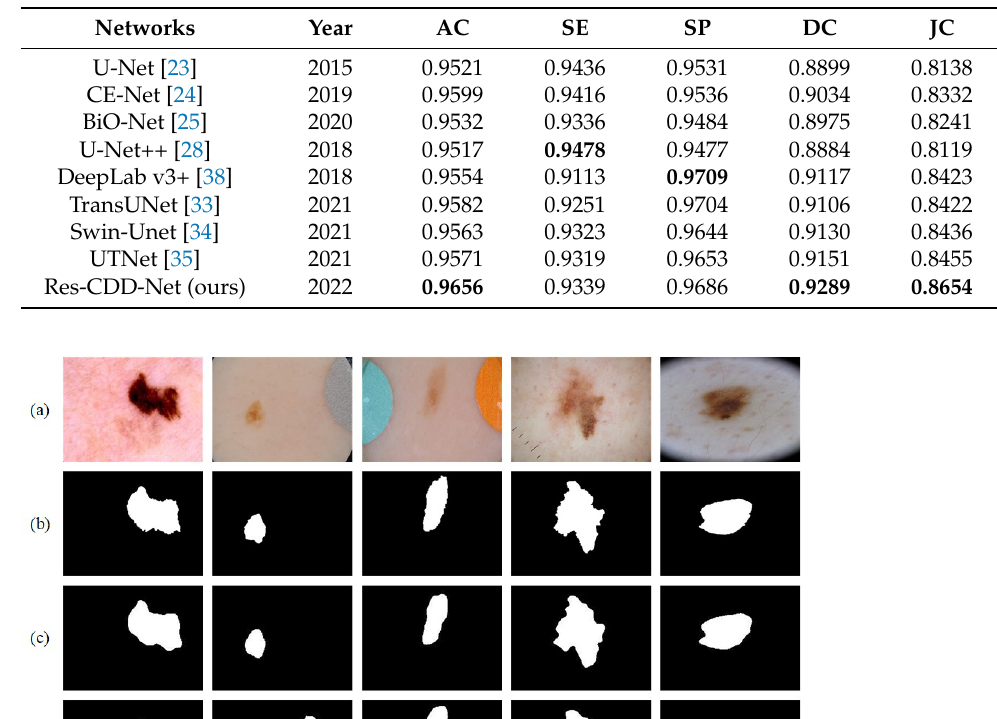
Table 6. Testing results of our Res-CDD-Net and other mainstream networks on the ISIC-2016 dataset.